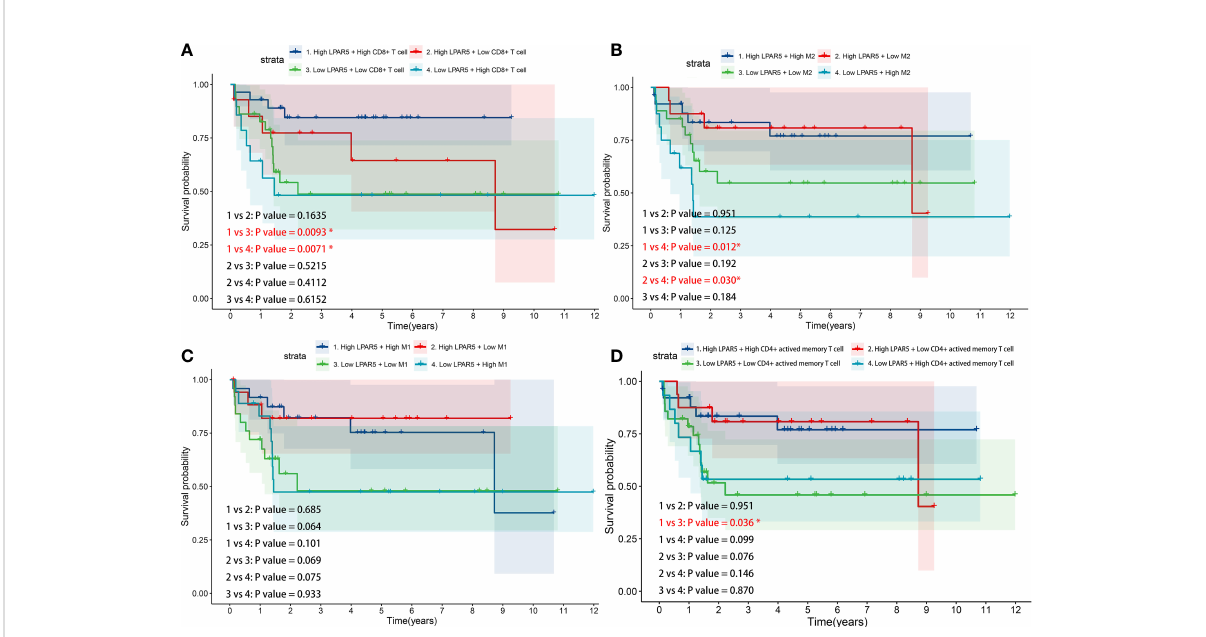
FIGURE 8 Survival analysis of LPAR5-expressing immune cells. (A) CD8 + T cell. (B) M2 macrophage. (C) M1 macrophage. (D) CD4 + activated memory T